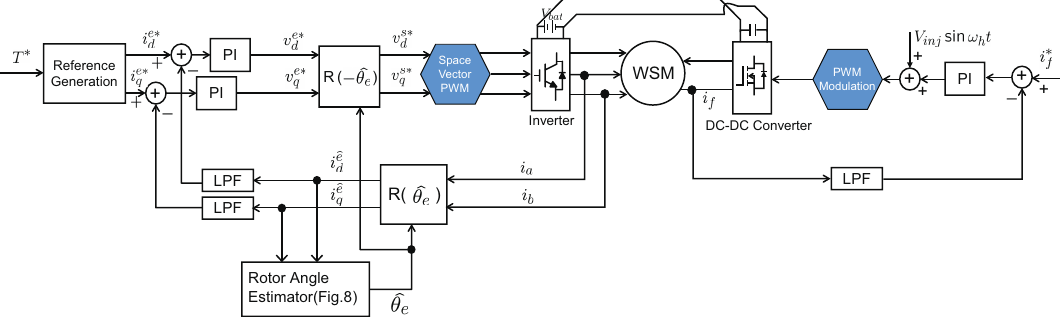
Figure 12. Block diagram of a proposed sensorless control method for a